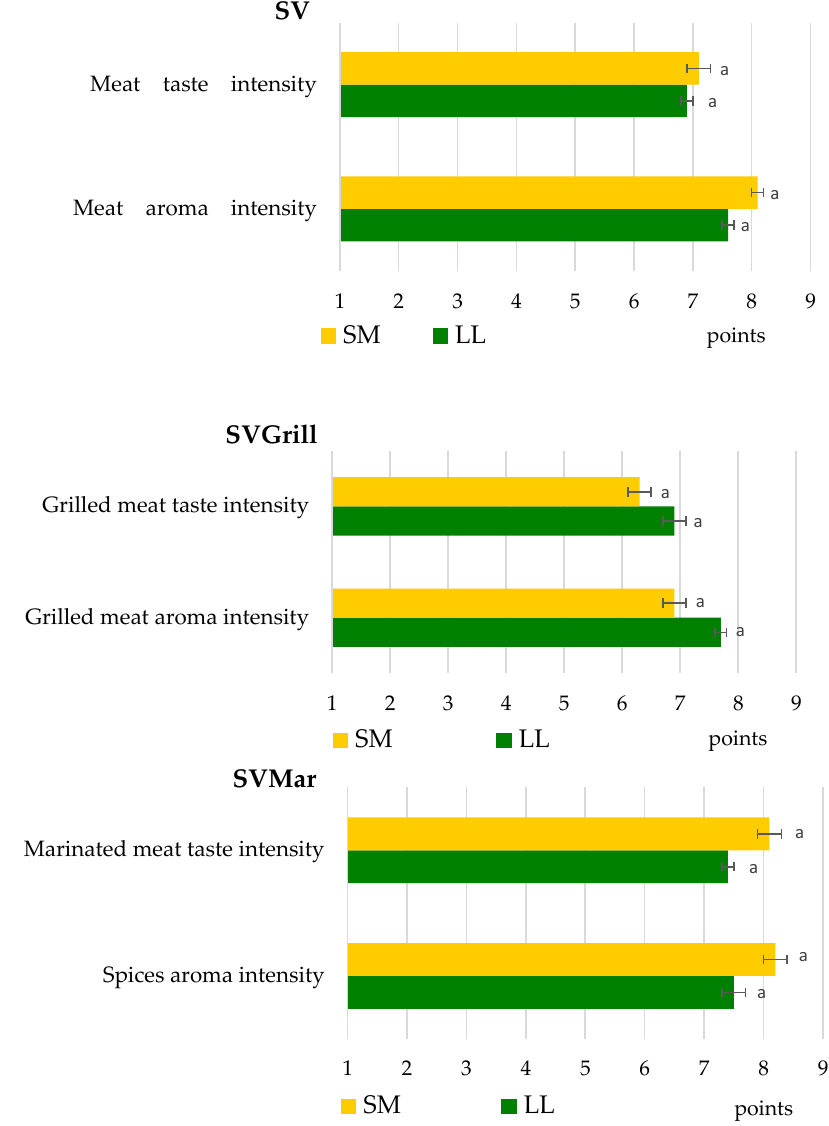
Figure 3. Comparison between specific aroma and taste characteristics of semimembranosus (SM) and longissimus lumborum (LL) muscles subjected to (1) sous vide (SV), (2) sous vide and grilling (SVGrill), and (3) marinating and sous vide (SVMar). Horizontal bars indicate standard error of the mean, and a represents values with the same letter not differing at p < 0.05.